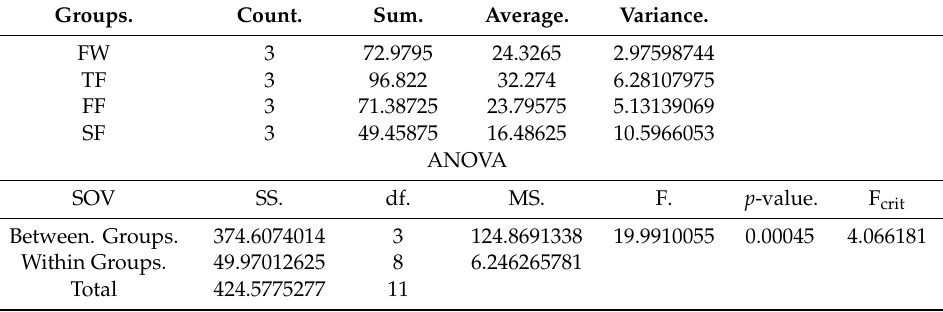
Table 7. ANOVA for the CS of RAGC mixes made with di ff erent types of e ffl uent at 28-days.